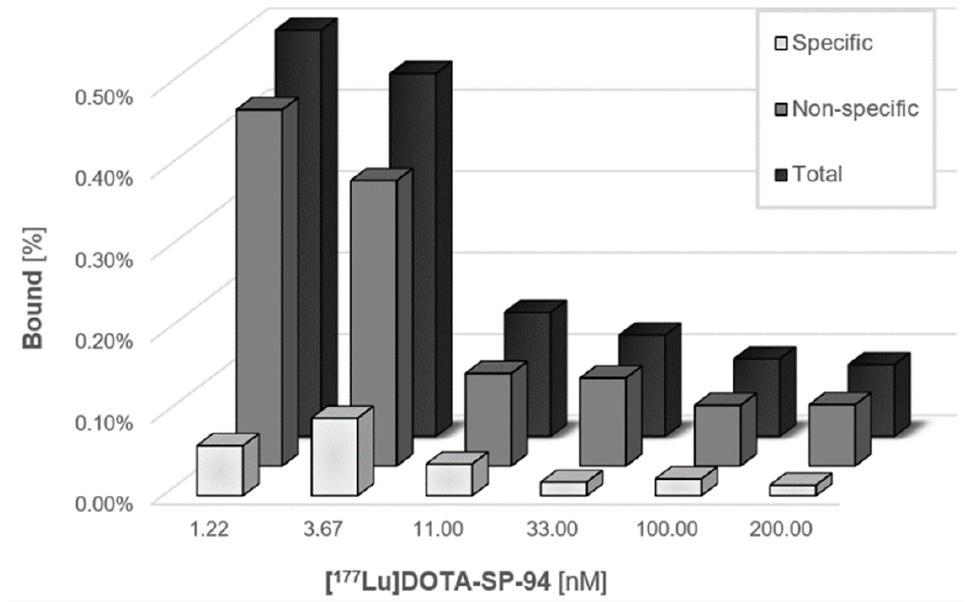
Figure 8. Graphical presentation of [ 177 Lu]DOTA-SP-94 binding to HepG2 cells. Due to the very short range of Auger electrons, internalization of the radiobioconjugate is required to achieve a therapeutic effect. The kinetics of internalization were performed on the SKOV-3 cell line with the use of Au@Pt-PEG-[ 131 I]trastuzumab. As presented in Figure 9, more than 90% of bioconjugate internalizes after 1 h and remains at a similar level for up to 24 h. Due to the lack of specific binding, internalization studies were not conducted on MDA-MB-231 cells.